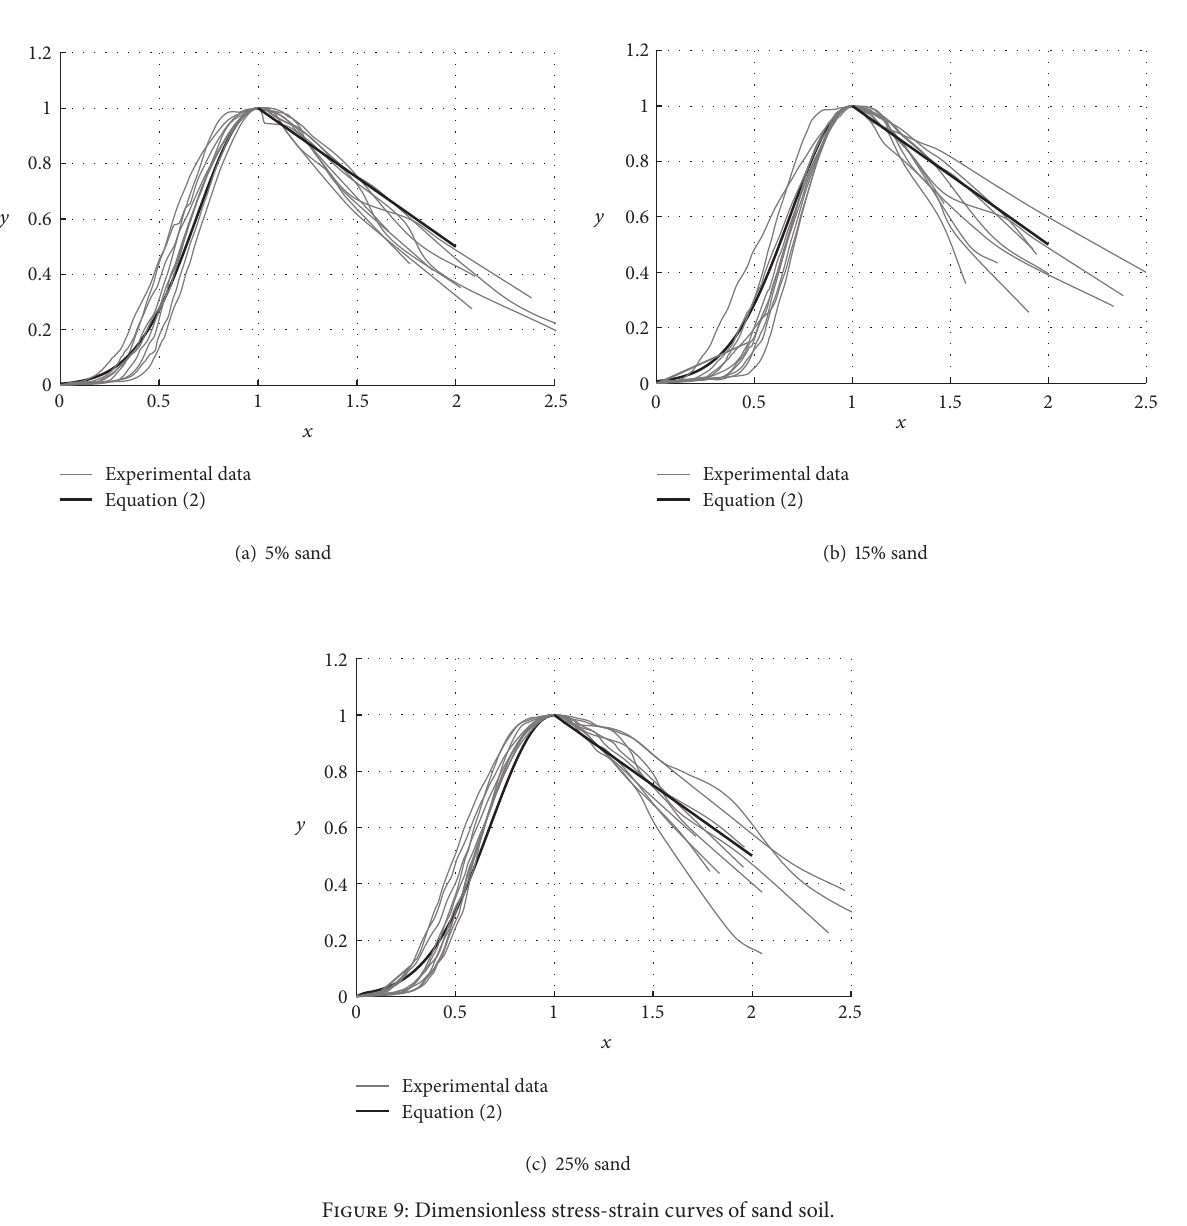
Figure 9: Dimensionless stress-strain curves of sand